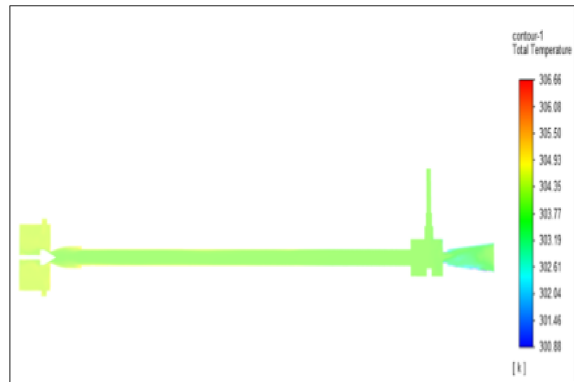
Figure 12. Brass at 4 bar.